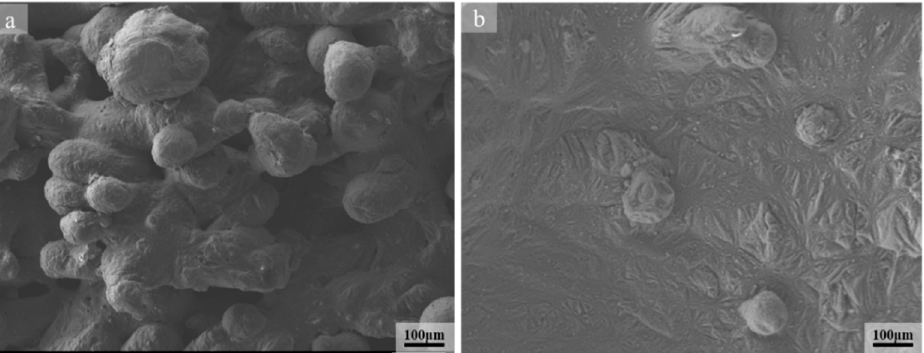
Figure 7. SEM images of SLM magnesium alloy under different energy densities: ( a ) is 26.79 J/mm 3 and ( b ) 156.25 J/mm 3 .